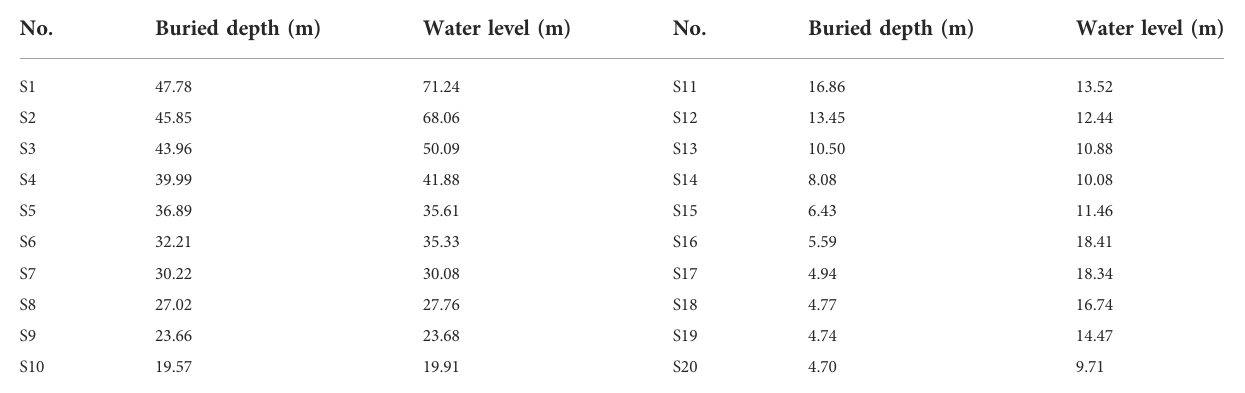
TABLE 3 Buried depth and the water level in the Yongding River pro fi